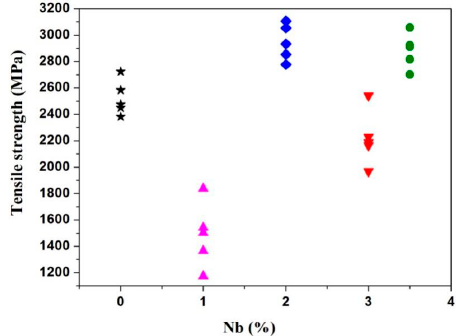
Figure 8. The strength distribution of the glass ‐ coated fibers with different content of Nb.